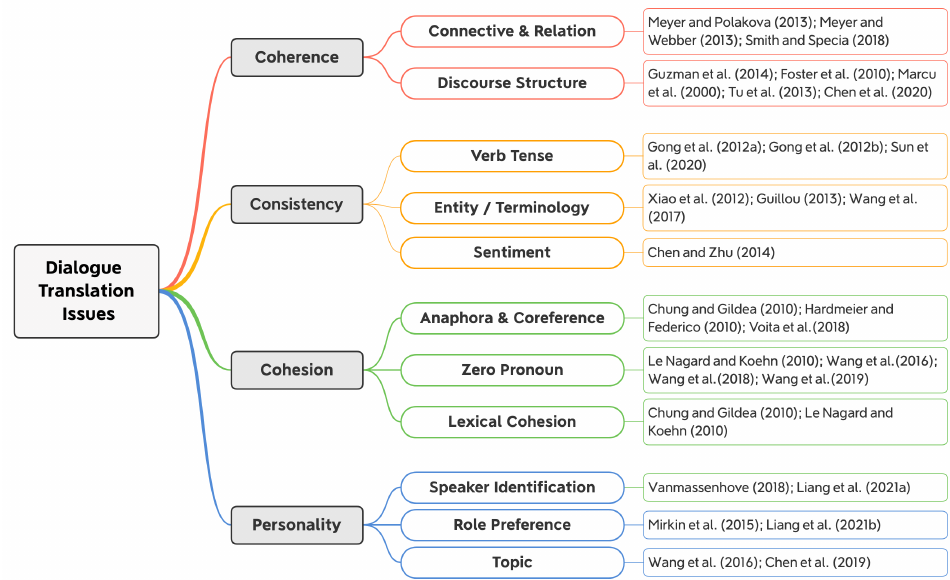
Figure 4. The overview of dialogue translation issues and sub-categories along with related